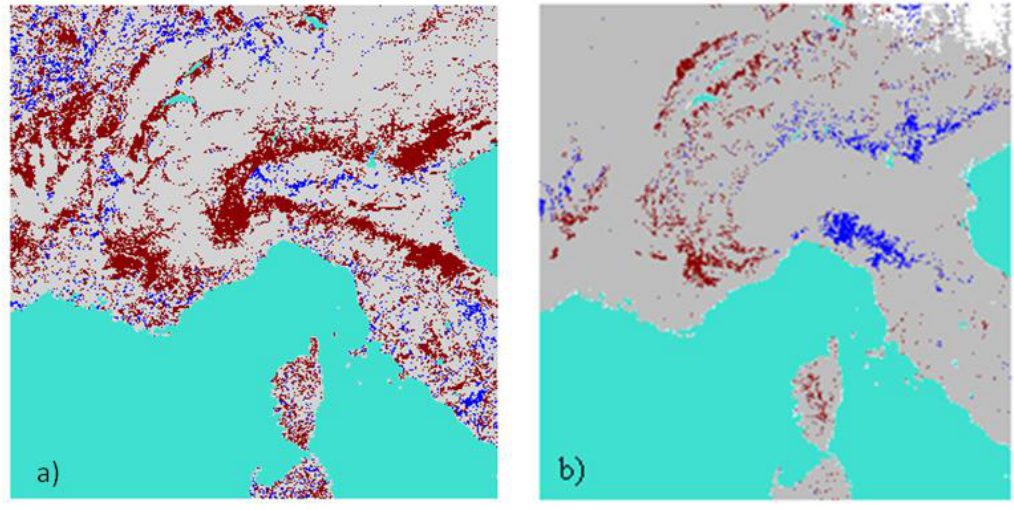
Figure 5. Difference between the snow cover maps of December 2008 and December 2003 (a), and of March 2009 and March 2004 (b). The areas where snow cover was present in 2008–2009 but not in 2003–2004 are represented in red, and those with snow cover in 2003–2004 but not in 2008–2009 are represented in blue. Pixels representing snow covered or snow free zones in both maps are gray; pixels representing water surfaces are turquoise, and cloudy pixels in one of the two images are